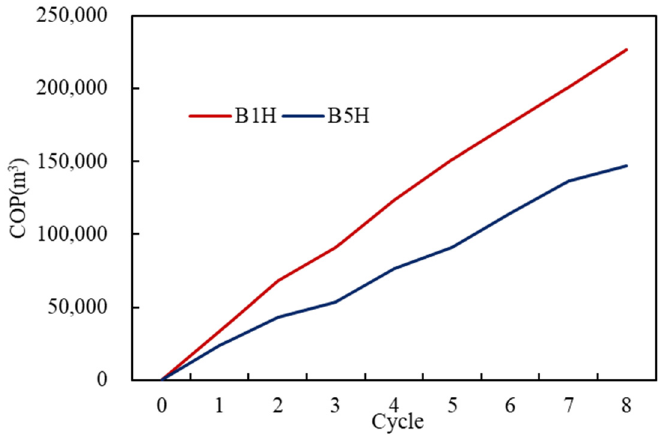
Figure 11. Prediction of the COP values of the two CSS horizontal wells by the optimized PA-LM